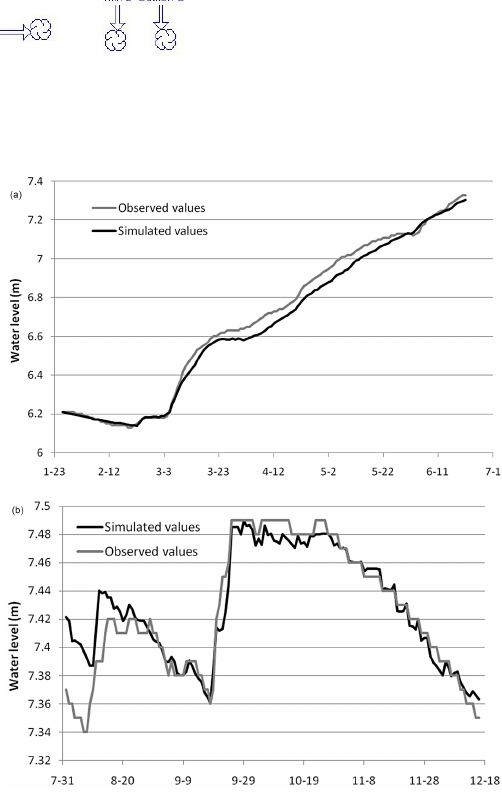
Figure 5. Calibration (a) and validation (b) results for water